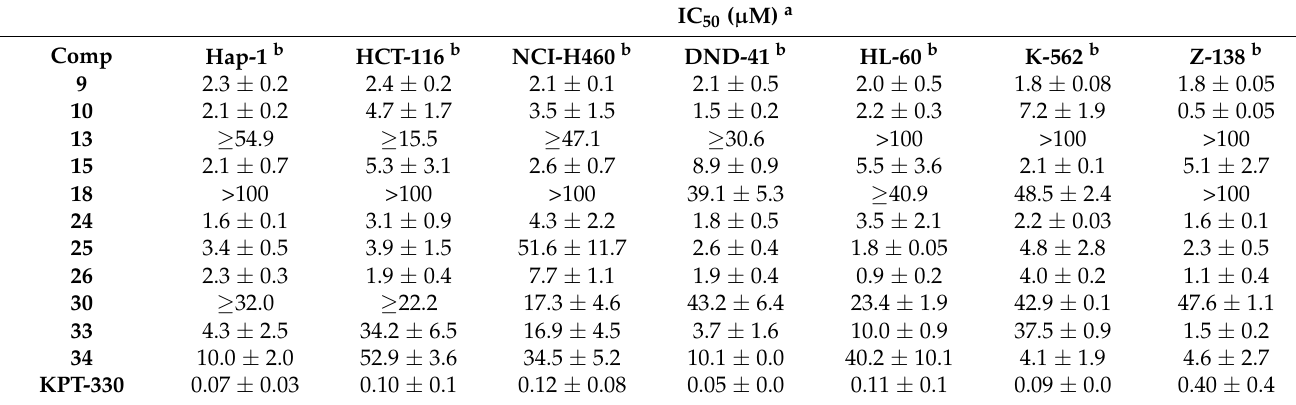
Table 1. Antiproliferative activity of the synthesized chalcones against different tumor cell